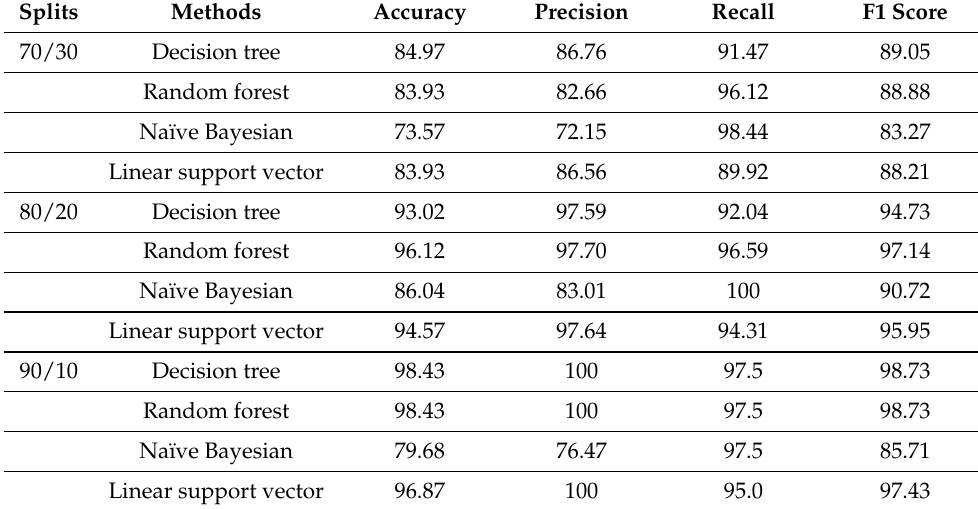
Table 5. Classification results of ML classifiers on embedded Arabic fake news